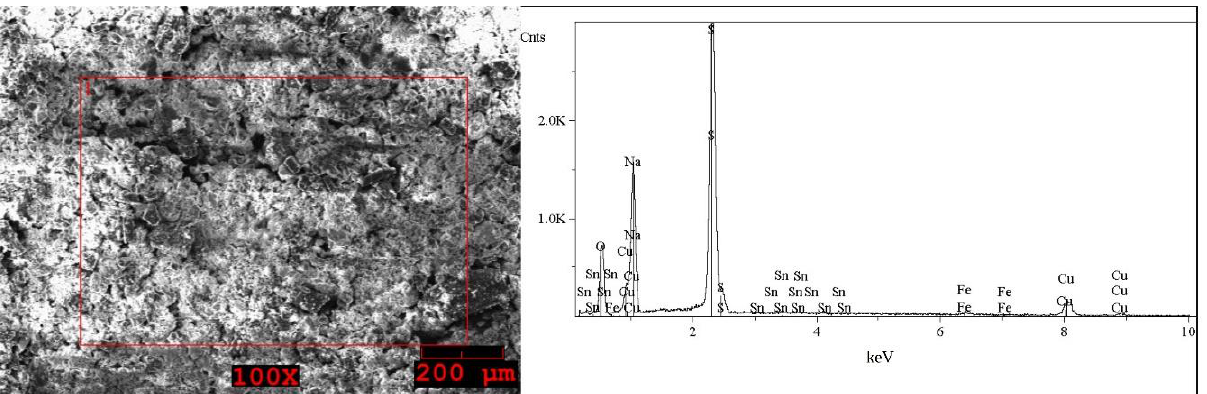
Figure 5. SEM image of the grey solid phase sample precipitated out from the post-leaching solution I and EDS spectrum taken from the area marked in the image.